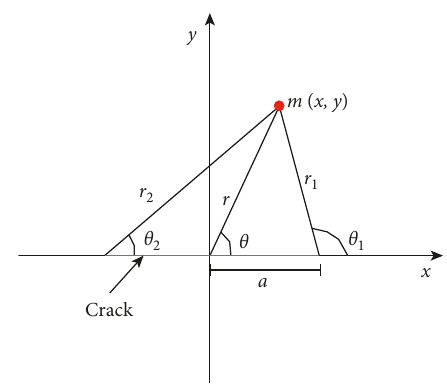
Figure 1: Relative position of point m and the